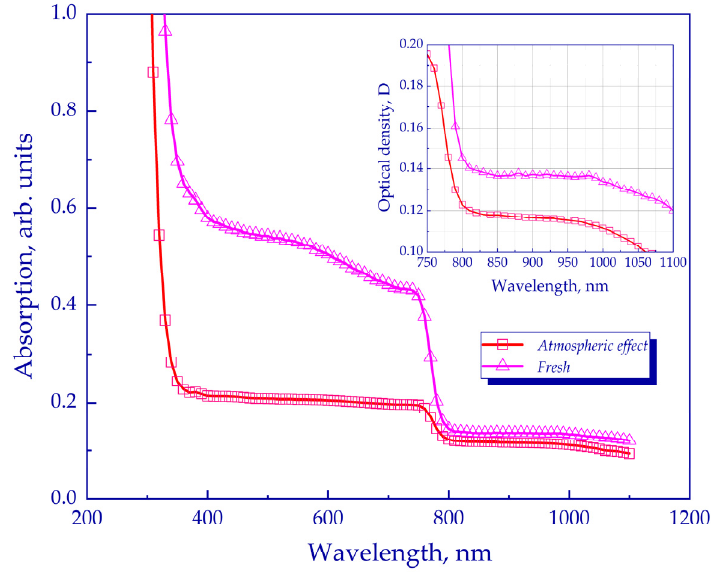
Figure 5. Variation in the absorption of perovskite films due to various factors.